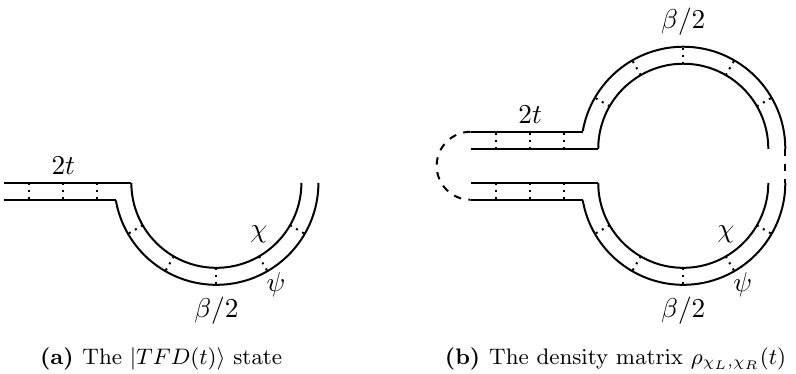
Figure 1. The graphical representations of (a) the j TFD ( t ) i state and (b) the reduced density operator (cid:26) (cid:31) ( t L ;(cid:31) R